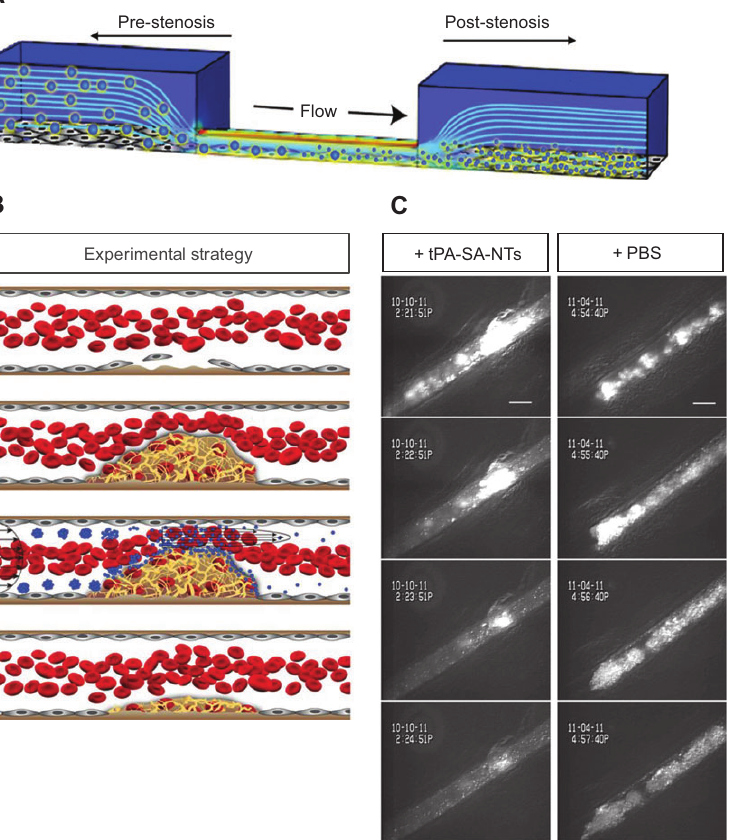
Figure 2 The shear-activated nanotherapeutics. (A) A microfluidic model of the vascular stenosis (90% lumen narrowing) showing the shear-induced dissociation of the microaggregates into the nanoparticles and their targeting to the stenotic and poststenotic region. (B) Experimental strategy: ferric chloride injury initiates the formation of a thrombus (top) that grows to partially obstruct blood flow (top middle). The intravenously injected microaggregates dissociate into the NPs at the thrombus site because of the rise in the local shear stress (bottom middle). The accumulation of the tPA-coated NPs and the binding to the clot at the occlusion site progressively dissolve the obstruction (bottom); (C) The intravital fluorescence microscopic images showing the fluorescently labeled platelets accumulated within a thrombus that partially occludes a mesenteric artery 8 min after injury. The clot on the left, treated with injection of the tPA-carrying microaggregates (50 ng tPA), is greatly reduced in size within 5 min after injection. The control vessel receiving the PBS injection (right) fully occludes over the same time period. Scale bar, 100 μ m; tPA-SA-NTs, tissue plasminogen activator-carrying shear-activated nanothera- peutics. From Korin et al. [65] modified with the authors ’ permission. Reprinted with permission from the American Association for the Advancement of